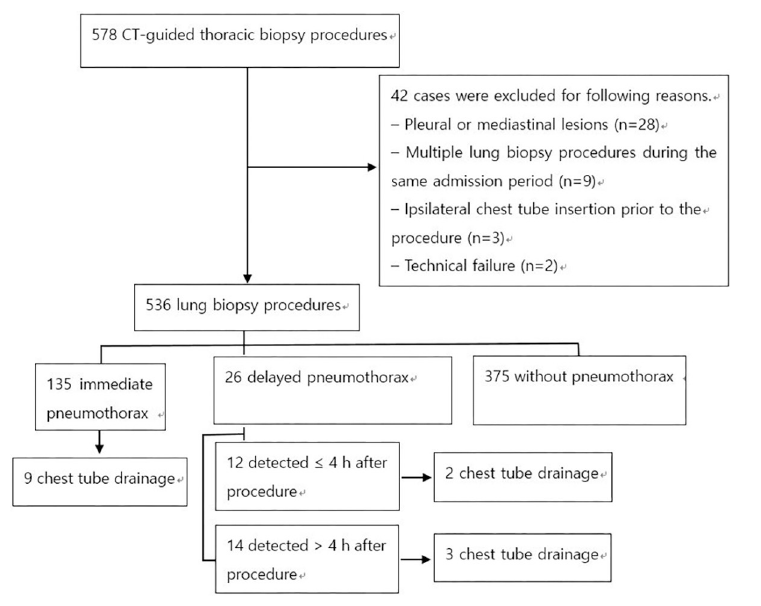
Fig 1. Flow diagram of the